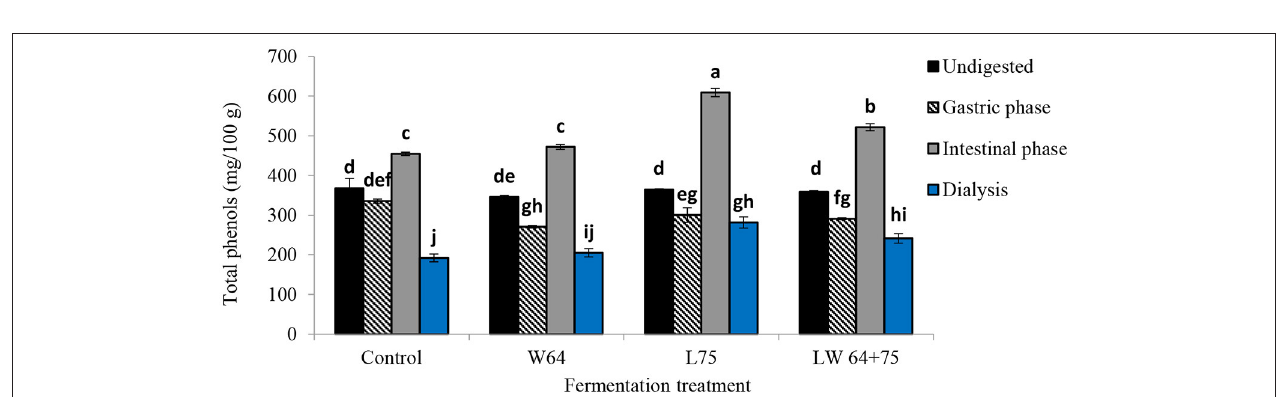
FIGURE 6 | Changes in total carotenoid content during fermentation of smoothies. Bars with different alphabetic letters are significantly different at p < 0.0001 level. W64 , Weissella cibaria 64; L75 , Lactobacillus plantarum 75 ; LW64 + 75 , W. cibaria 64 + L. plantarum 75; D0, day 0; D2, 2 days; D7, 7 days; DW, dry weight; non-fermented smoothies (control).